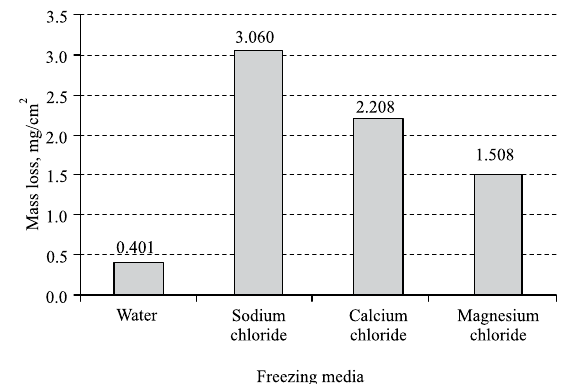
Fig. 8. The dependence of mass loss on saline solution type in specimens with Portland cement and NST additive after 56 freeze-thaw